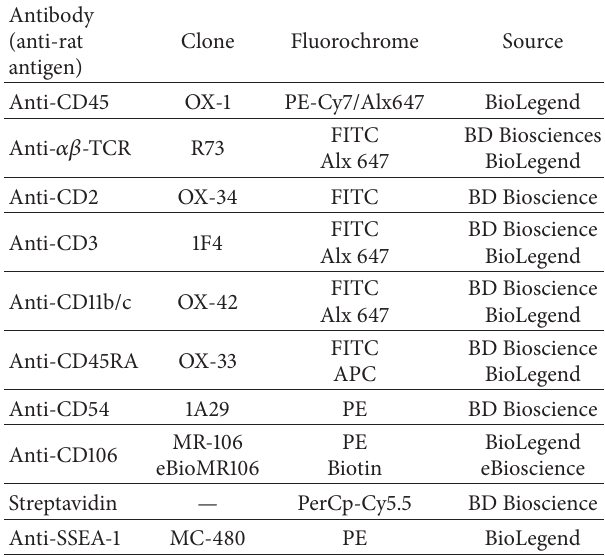
Table 1: Antibodies employed in staining for identification and sorting of rat BM-derived populations including